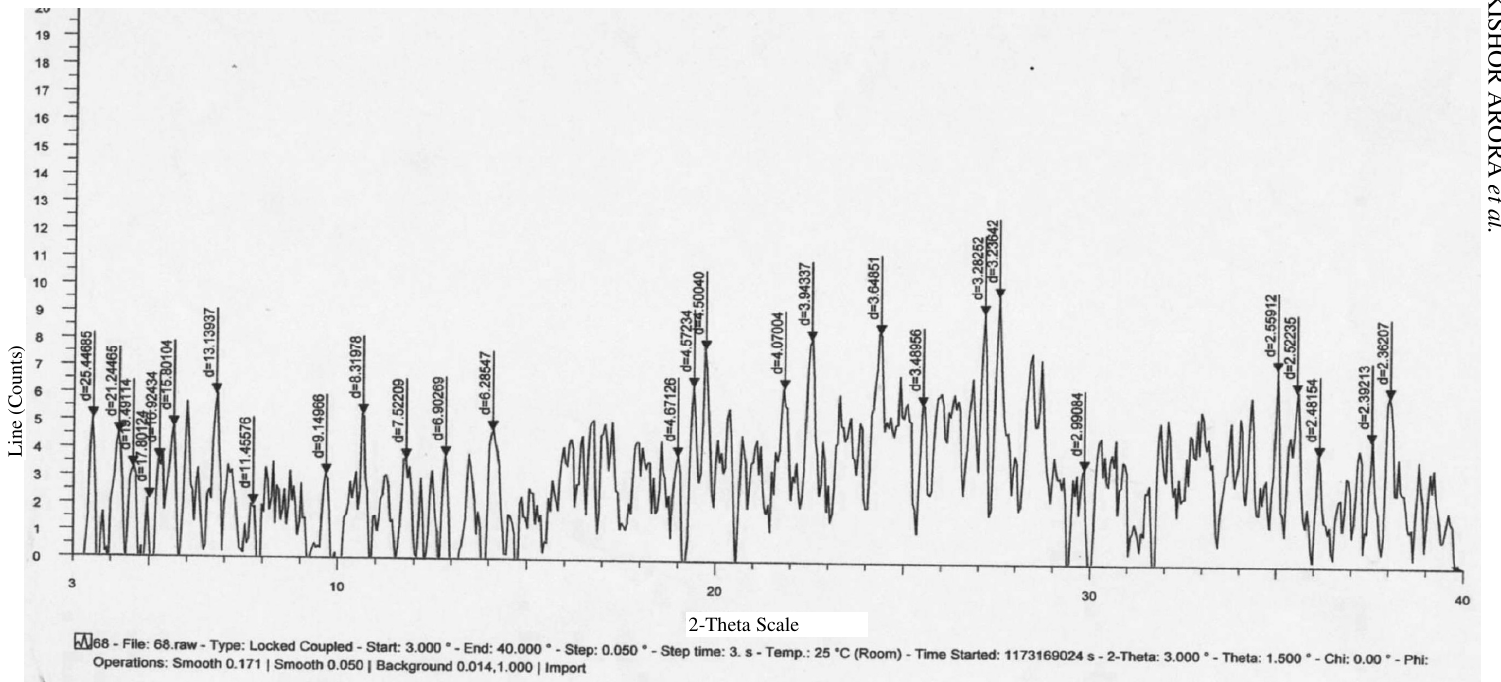
Figure 3 . X-Ray diffraction for [Th(2-FAPy)